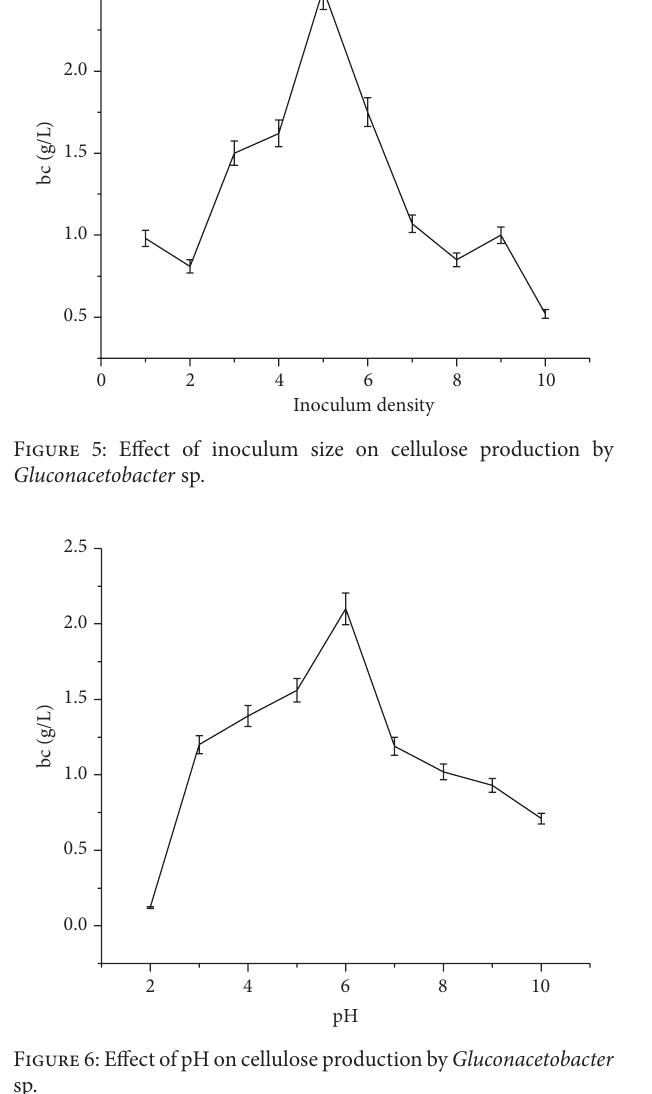
Figure 6: Effect of pH on cellulose production by Gluconacetobacter sp.